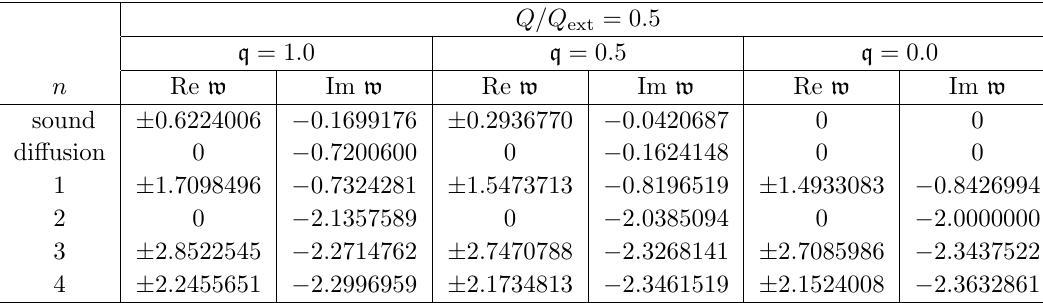
Table 2. Numerical values of frequencies corresponding to the two hydrodynamic and the lowest four non-hydrodynamic quasinormal modes in spin 0 channel at real